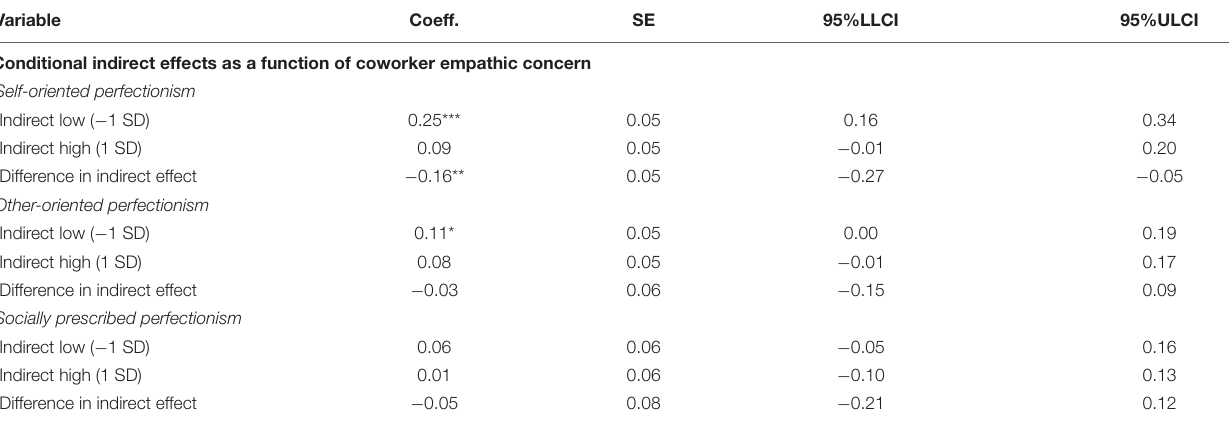
TABLE 5 | Bootstrapping results for moderated mediation effects.